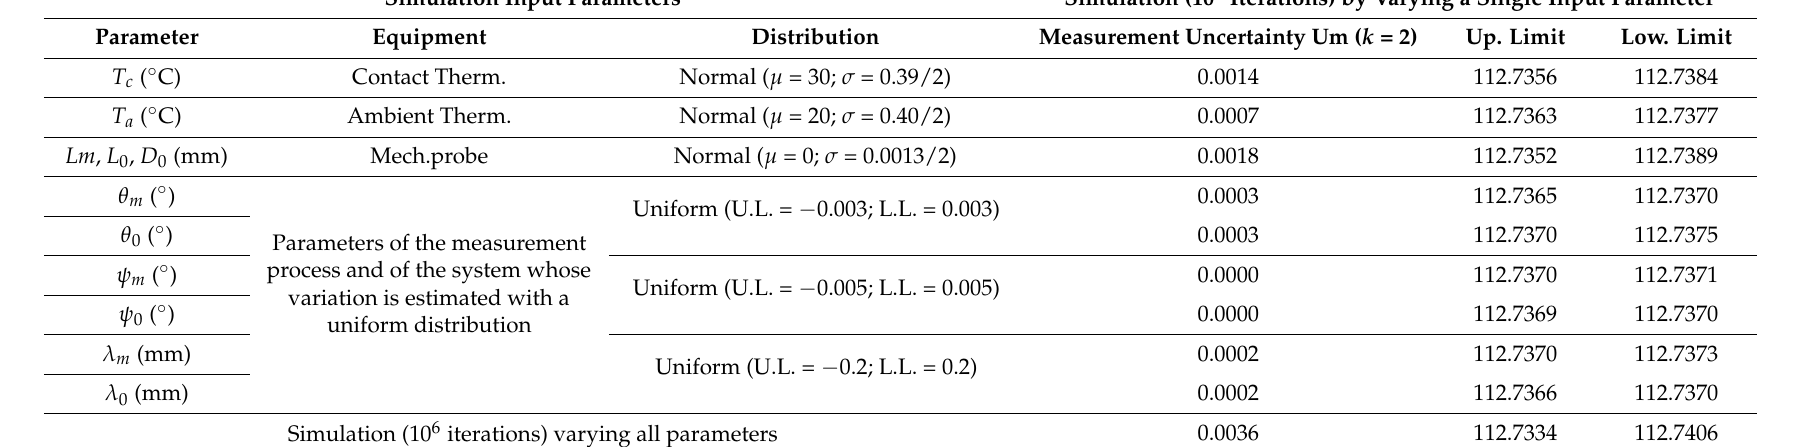
Table 4. Distribution and range of variation assigned to each parameter. Estimated uncertainty in each case (for each parameter and at the end of the table for all parameters at a